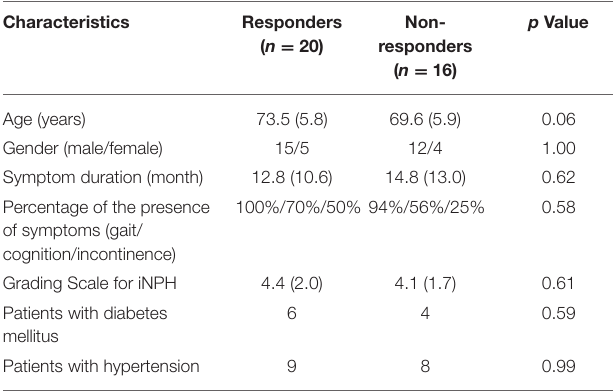
TABLE 1 | Demographic and clinical characteristics of